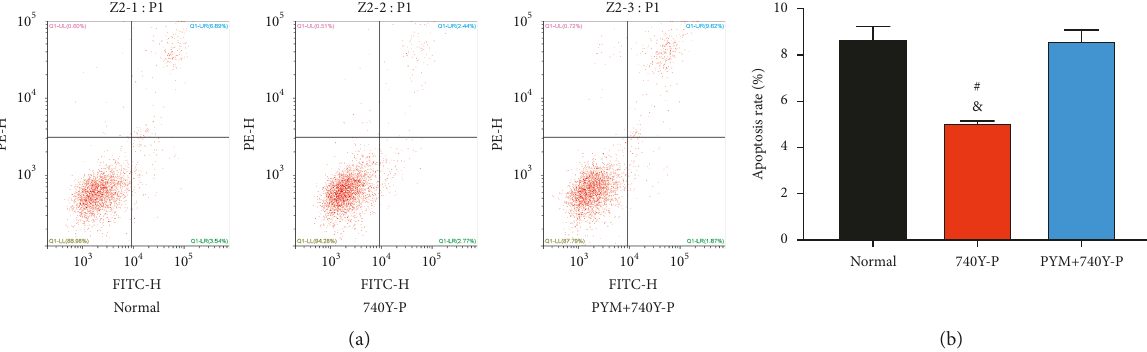
0 . 05; compared with the PYM+740Y-P group, & P <